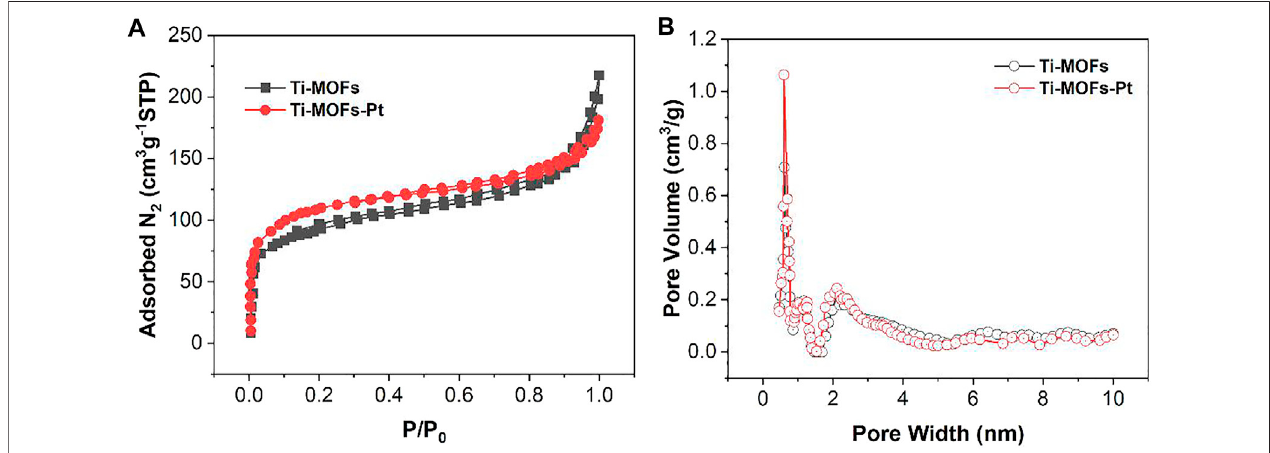
FIGURE 5 | CV of GCE, Ti-MOFs/GCE and Ti-MOFs-Pt/GCE in 0.1 M KCl solution containing 2 mM K 4 Fe(CN) 6 /K 3 Fe(CN) 6 (scan rate: 50 mV/s).